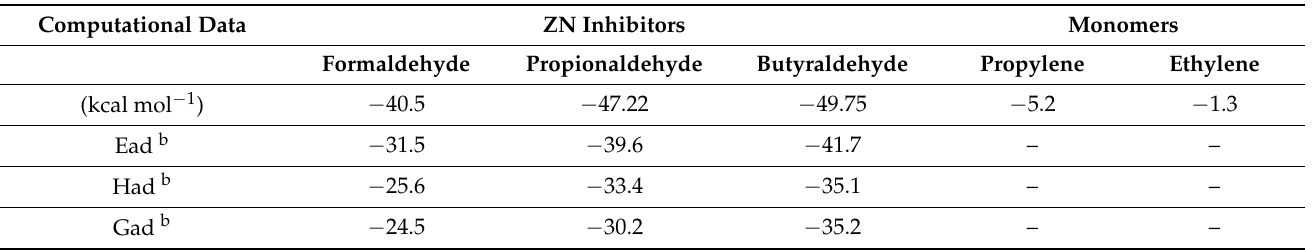
Table 1. Binding energies, Ead, in kcal mol − 1 , for the interaction of different poisons with Ti and Mg in cluster.